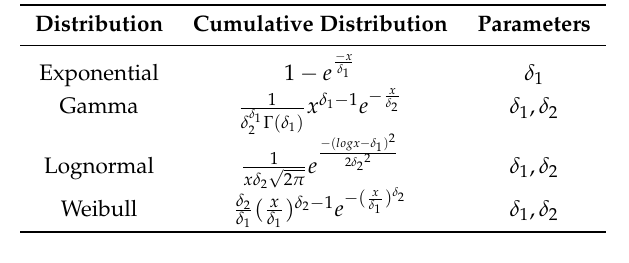
Table 1. List of the selected marginal distribution functions and parameters.